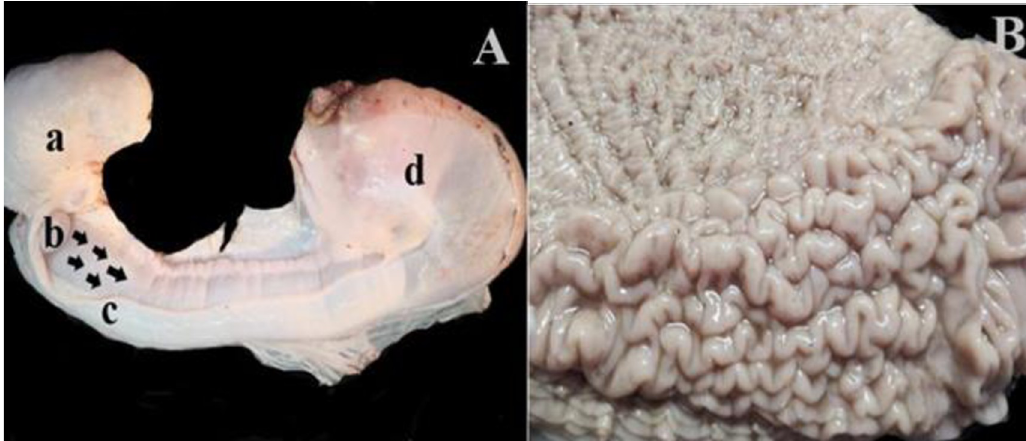
Fig 2. The anatomical site of ALNA. (A) Lateral view of the anatomical location of ALNA within a triangular zone (arrows); (a) the second compartment of stomach; (b) isthmus; (c) ALNA;(d) non-ALNA of the cardiac glandular area of the third compartment; (e) the fundic glandular area and pyloric glandular area of the third compartment. (B): Apparent distinction between the ALNA (lower, the mucosal folds were thick and elevated) and non-ALNA (upper, the mucosal folds were